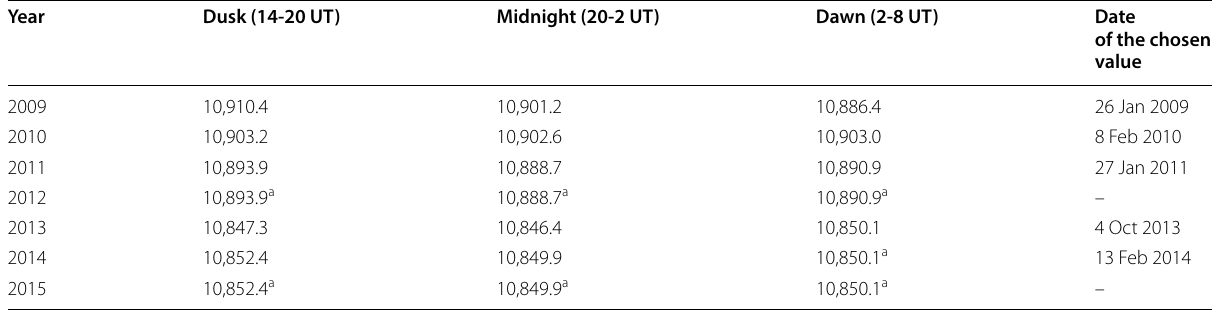
Unit: nT a We used the same corresponding value in the previous year